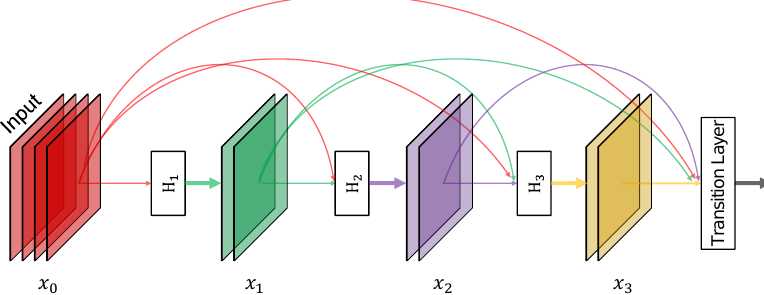
Figure 2. A 4-layer dense block. Each layer takes all preceding feature-maps as input and serves as input for all subsequent layers. H i denotes the operation BN-ReLU-Conv 1 × 1 -BN-ReLU-Conv 3 × 3